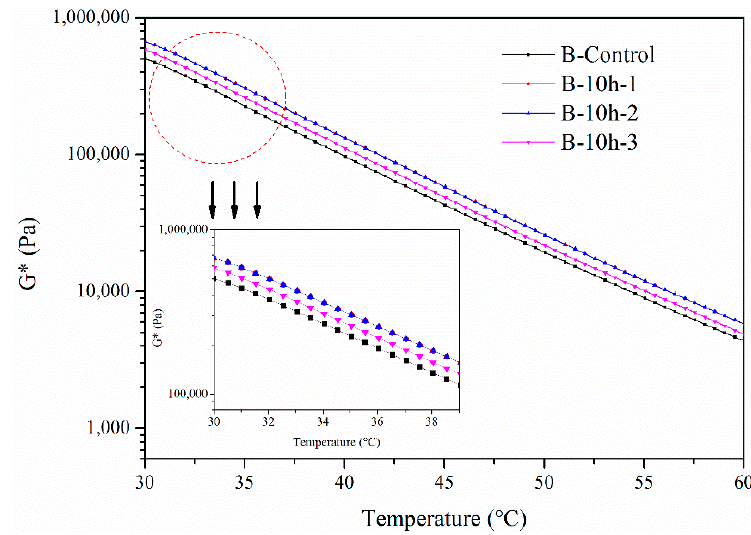
Figure 6. Complex modulus of B aged by UV radiation for 10 h.